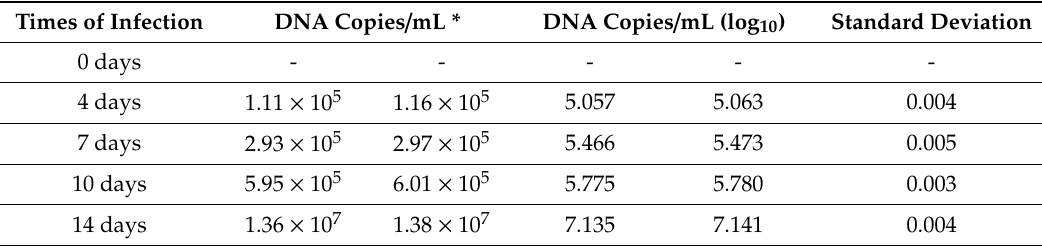
Table 1. Human cytomegalovirus (HCMV) DNA quantitation in infected primary human dermal fibroblasts at the indicated times post-infection (p.i.).